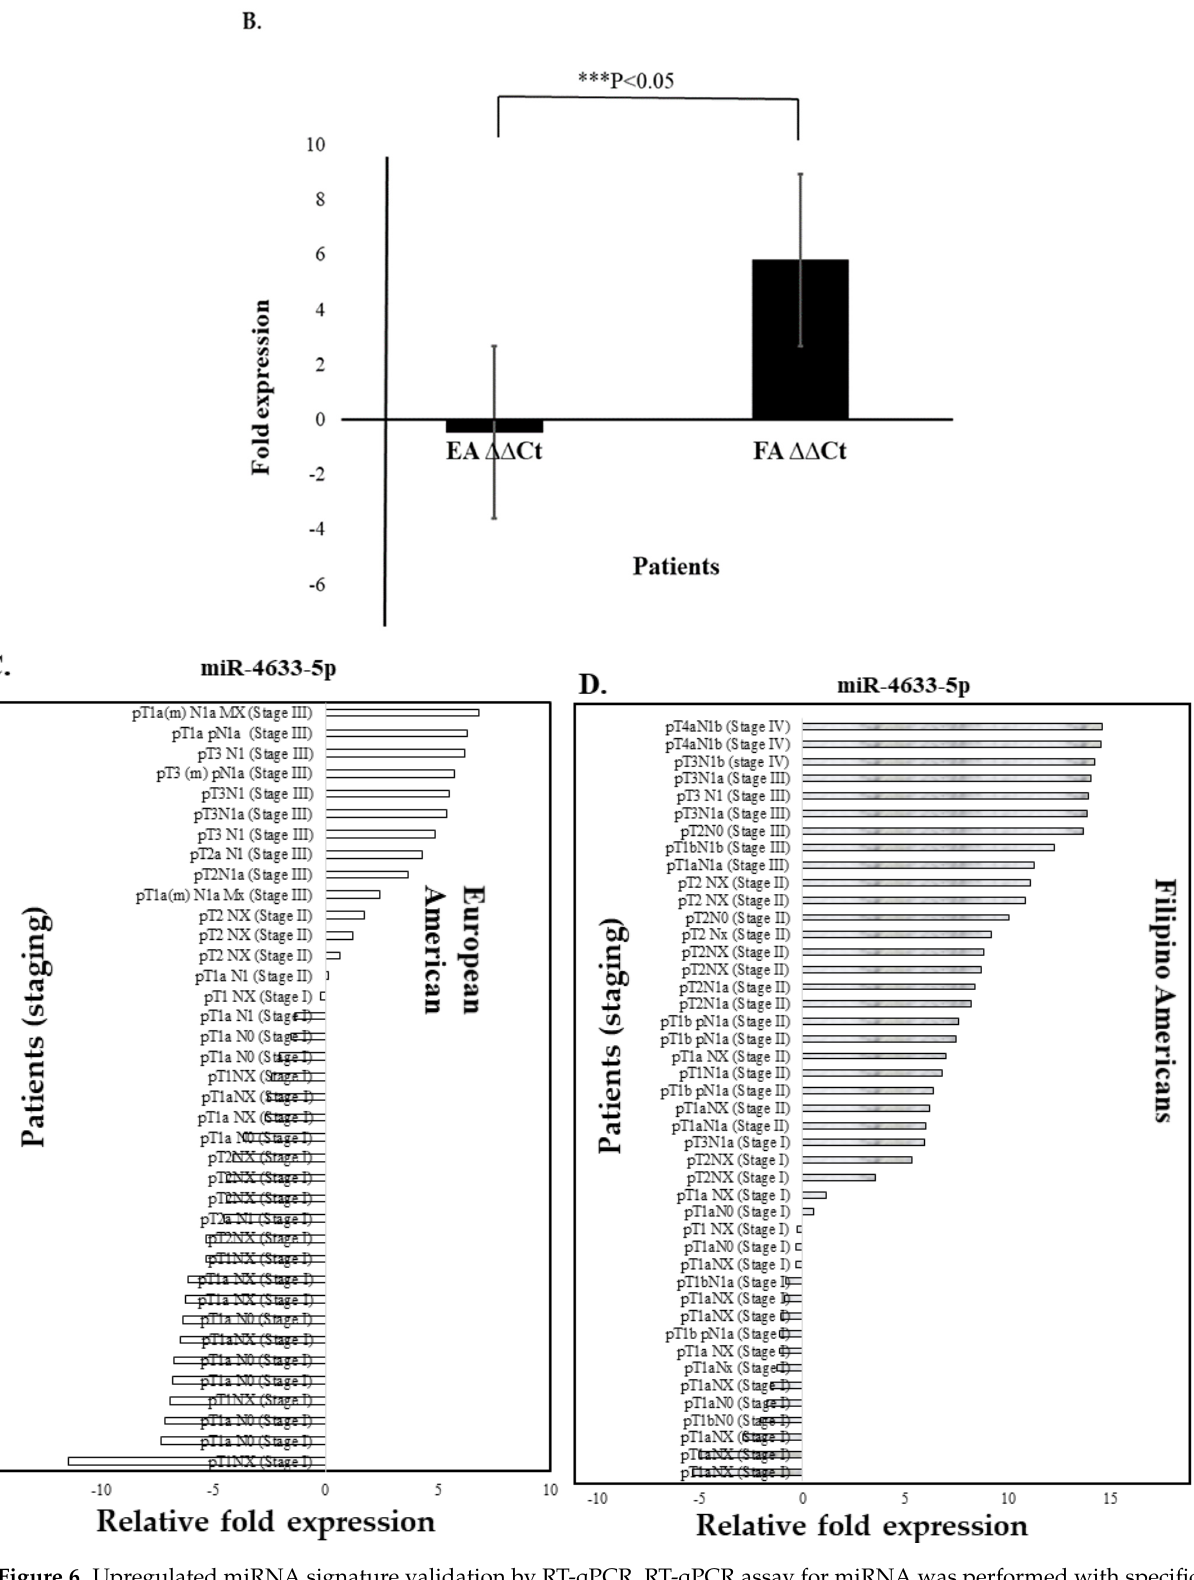
Figure 6. Upregulated miRNA signature validation by RT-qPCR. RT-qPCR assay for miRNA was performed with specific primers for miR-4633-5p gene. ( A ) Relative expression ( ∆∆ Ct) and ( B ) fold expression values were compared in European Americans versus Filipino Americans. ( A ) Significantly (*** p < 0.0001) higher expression of miR-4633-5p was shown in Filipino Americans ( n = 46) versus European Americans ( n = 43). An increasing trend of higher expression of miR-4633-5p was observed in larger tumor size and staging (pTNM) in ( D ) Filipino Americans compared to ( C ) European